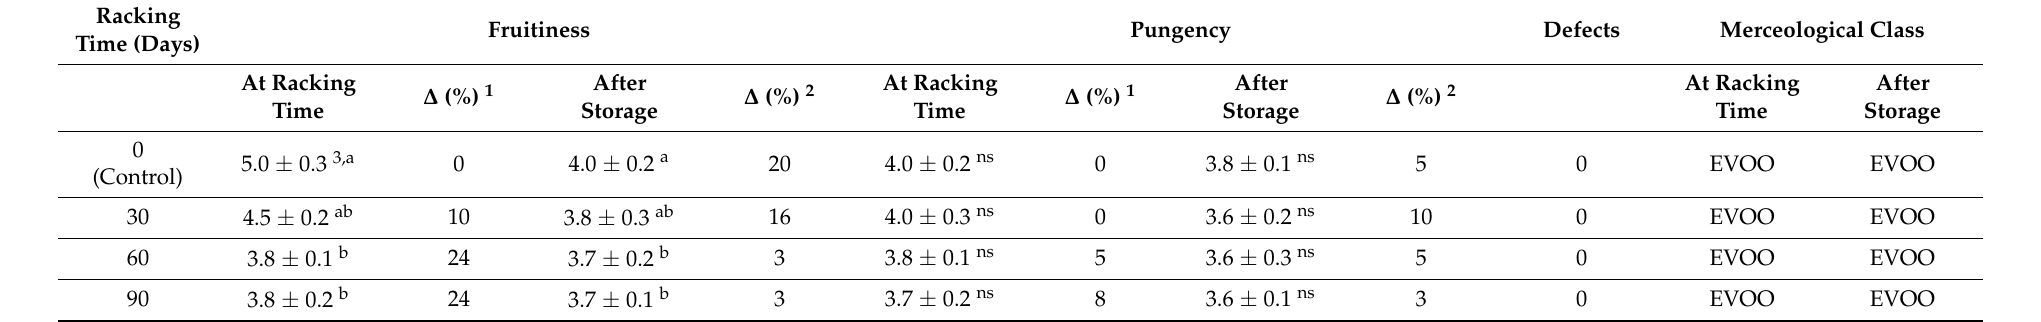
Table 7. Sensory profile of Coratina monocultivar EVOO evaluated at racking time and after seven months of